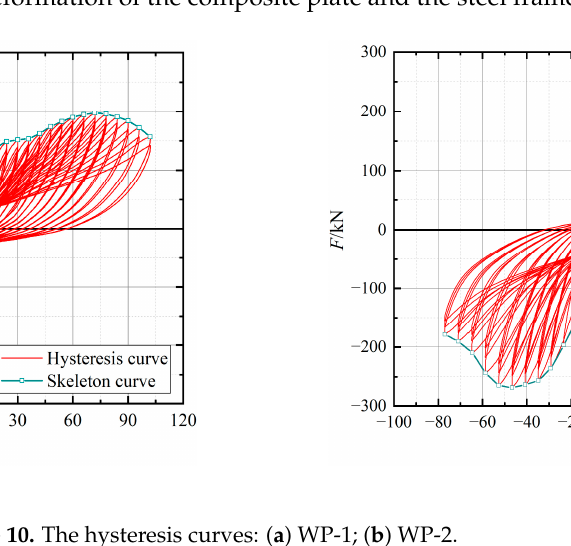
In the elastic phase, the load–displacement curve is linear, the hysteresis loop’s sur-